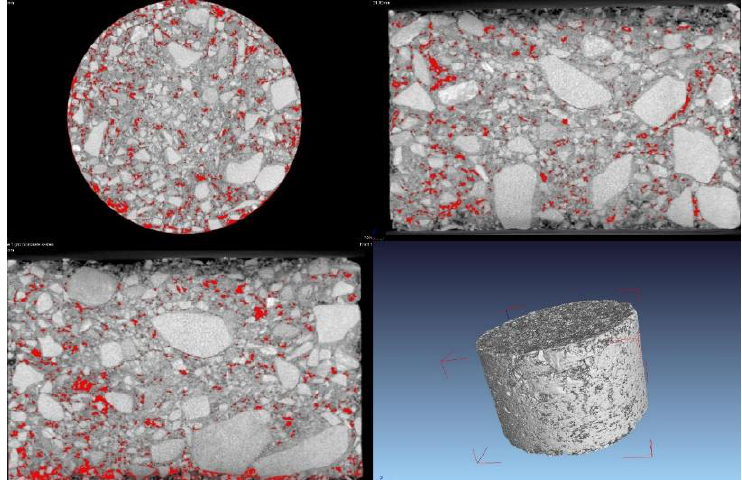
Figure 3. Three views and three-dimensional reconstruction image of a specimen.